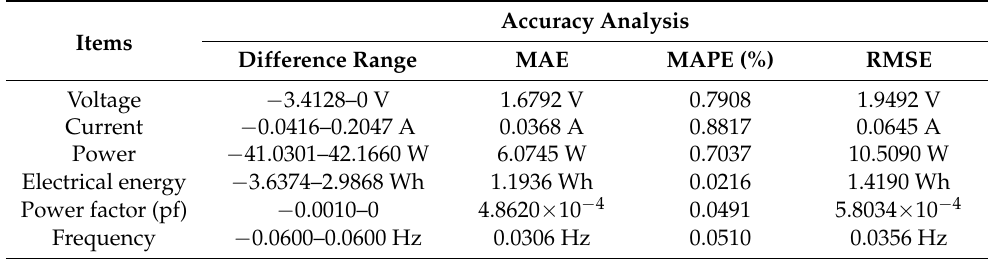
Table 4. Close agreement analysis of proposed AC power monitoring system for air